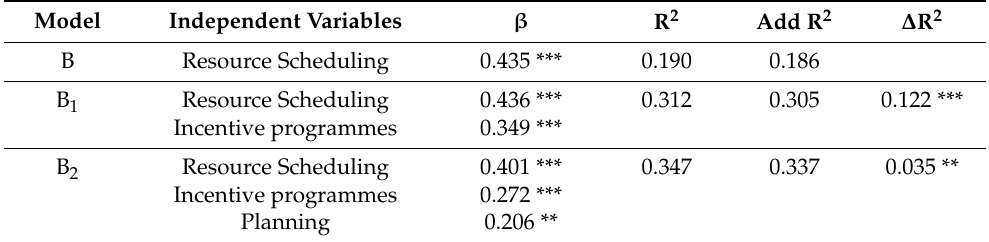
Table 3. Forward MRA models for SP.